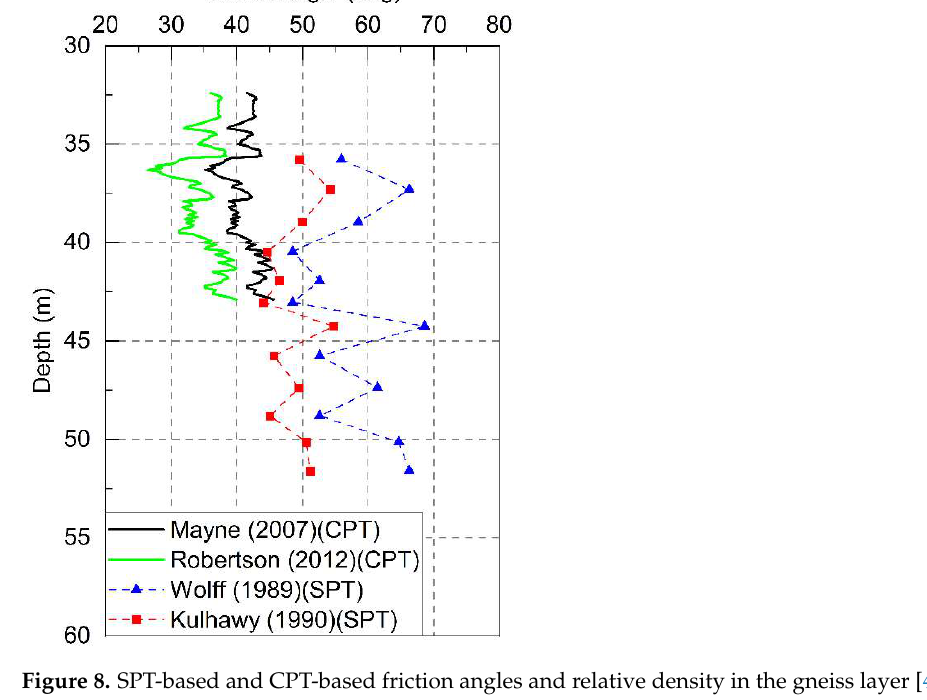
Figure 8. SPT-based and CPT-based friction angles and relative density in the gneiss layer [41–44].